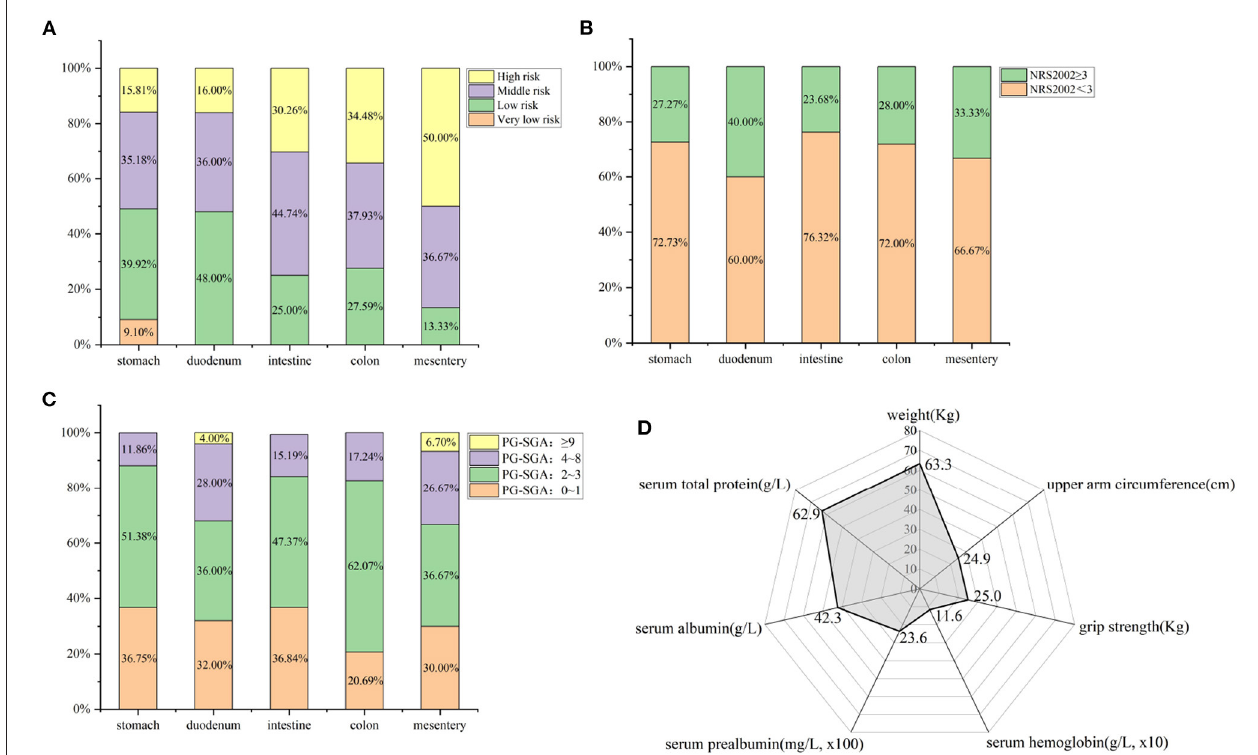
FIGURE 1 | Baseline data of 413 GIST patients at admission. (A) Disease distribution according to different tumors; (B) NRS2002 nutritional risk screening; (C) PG-SGA nutritional assessment; (D) Other nutrition-related indicators